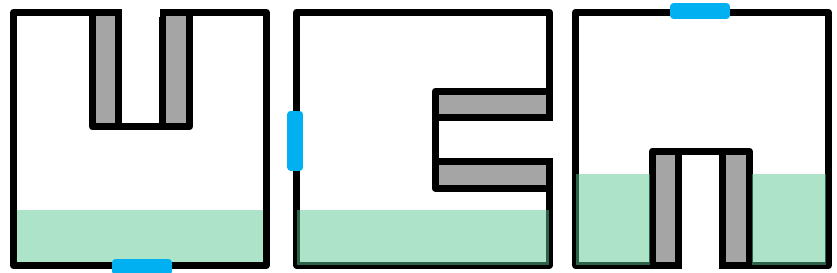
Figure 4. The leakage prevention design: liquid in the container in different tilted states.